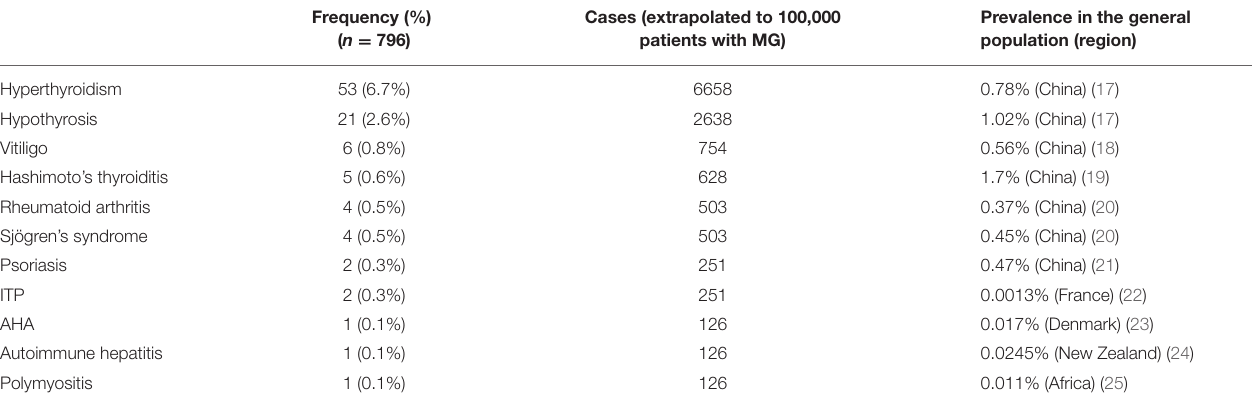
TABLE 2 | Comorbid ADs in patients with MG.